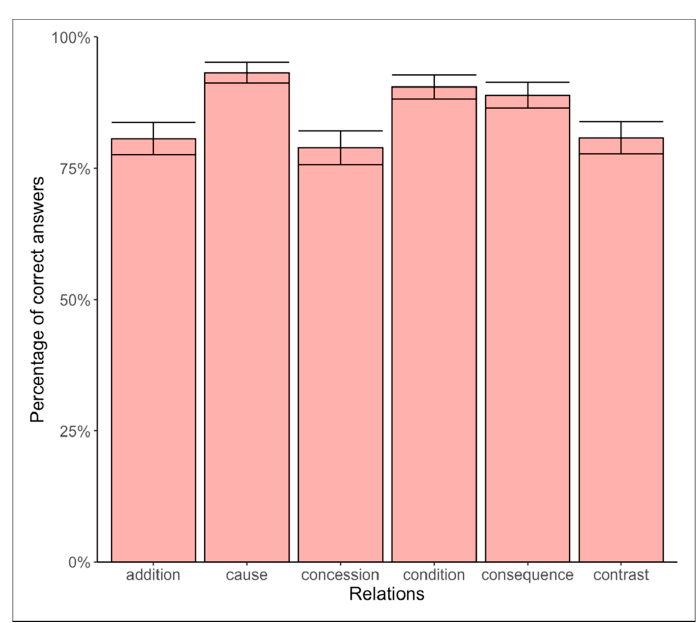
Figure 5. Percentage of correct answers by native speakers per relations (CI of 95% as error bars).